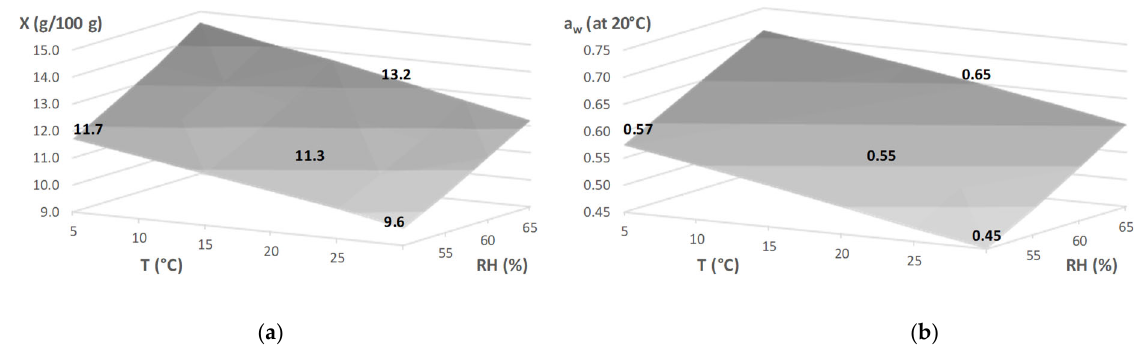
Figure 1. Water content (g/100 g, wet basis) of pasta prepared with 100% durum wheat depending on temperature and relative humidity ( a ) and water activity measured at 20 °C of the same pasta after reaching of equilibrium at the indicated temperature and humidity conditions ( b ). Calculations based on the desorption curves of De Temmerman et al. [16].